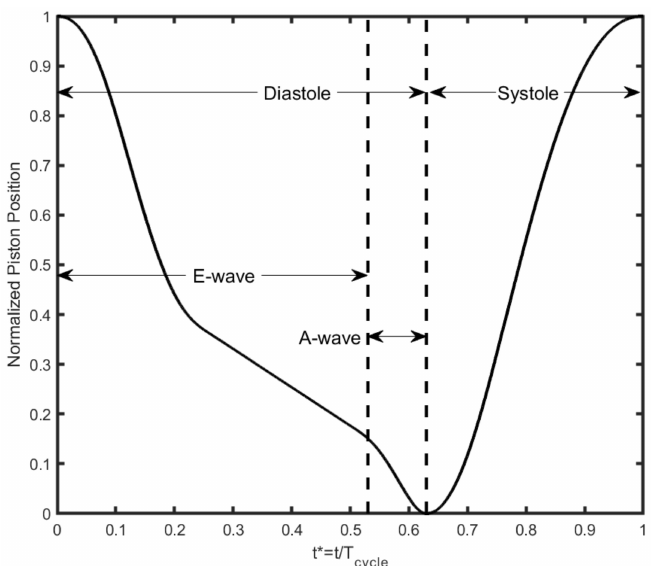
Figure 4. Position waveform used to actuate the linear motor in the heart simulator. The position and time are normalized so that different stroke lengths and heart rates can be selected. The A wave is integrated in the waveform.